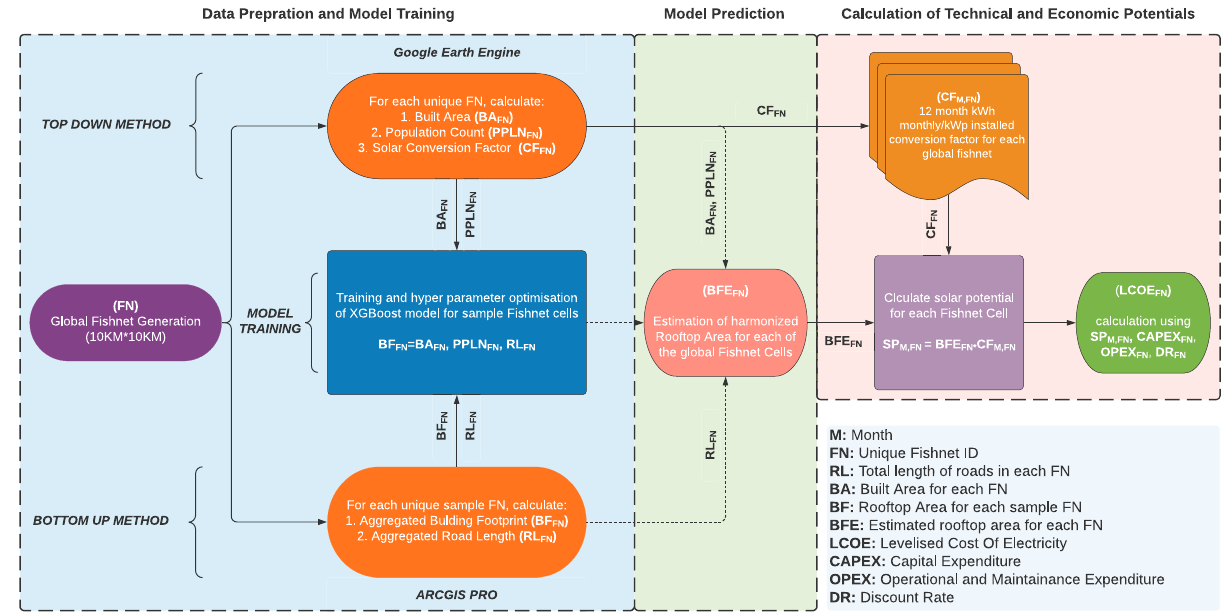
Fig. 1 Framework for assessment of RTSPV ’ s global technical potential and costs. The framework developed in this study starts with data preparation and mapping of various geospatial metrics to both Top-down and Bottom-up pathways. Further, the machine learning model is trained and used to estimate BFE FN values from BA FN, PPLN FN , and RL FN values. Next, the BFE FN values are used to calculate the technical potential (SP) with the aid of the conversion factors (CF). Finally, the calculated potential dataset is used to map the Levelised Cost of Electricity (LCOE) values using IRENA ’ s renewable power generation cost data. The detailed framework is described in the “ Results ” and “ Methods ” sections. Model parameters and regional mappings are provided in Supplementary Tables 6, 8 – 10 and Supplementary Fig. 3a –